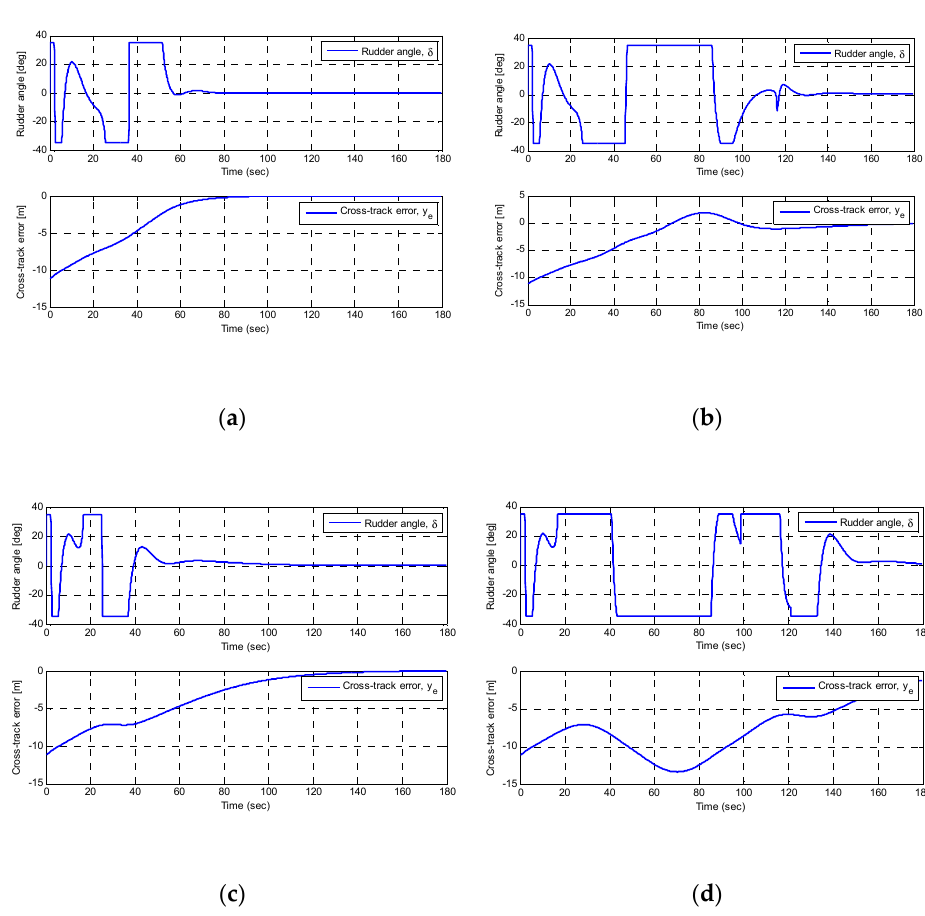
Figure 12. Rudder angle, cross-track error from the simulations: ( a ) round obstacle with collision risk; ( b ): round obstacle without collision risk; and ( c ) rectangular obstacle with collision risk; ( d ): rectangular obstacle without collision risk.